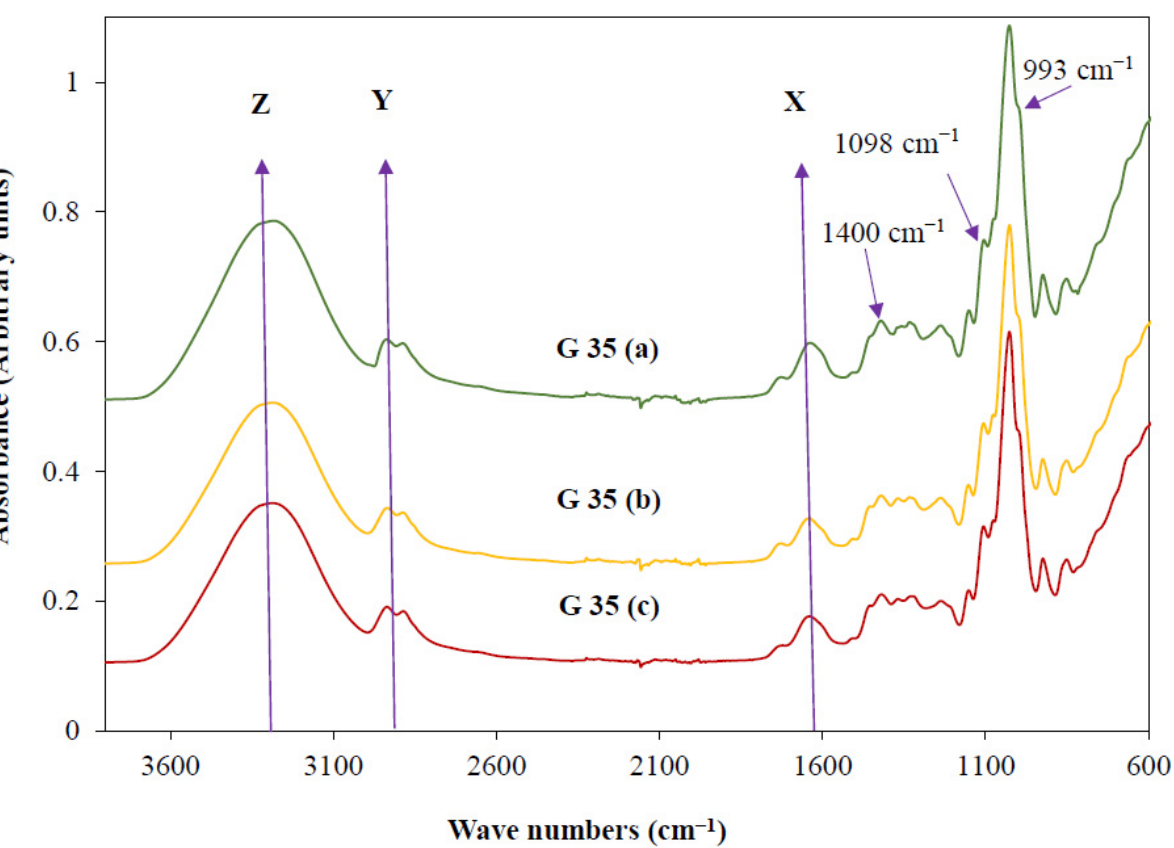
Figure 4. Fourier Transform Infrared (FTIR) spectrum for hot-pressed film prepared using 35% glycerol (G 35) with a pressure of 0.28 t (G 35 a), 0.42 t (G 35 b), and 0.84 t (G 35 c).